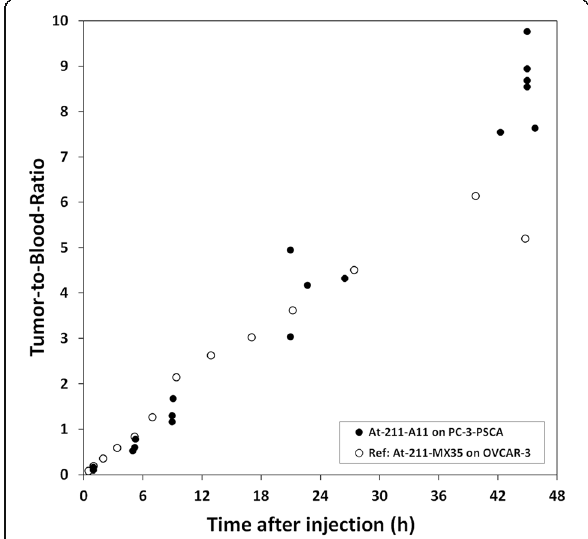
Fig. 1 The tumor-to-blood ratio (of %IA/g) of 211 At-A11 on s.c. PC3- PSCA macrotumors plotted versus time after injection. Included for comparison is the tumor-to-blood ratio of 211 At-MX35-F(ab ’ ) 2 , which was shown to be therapeutically efficient on macrotumors in previous studies of ovarian cancer